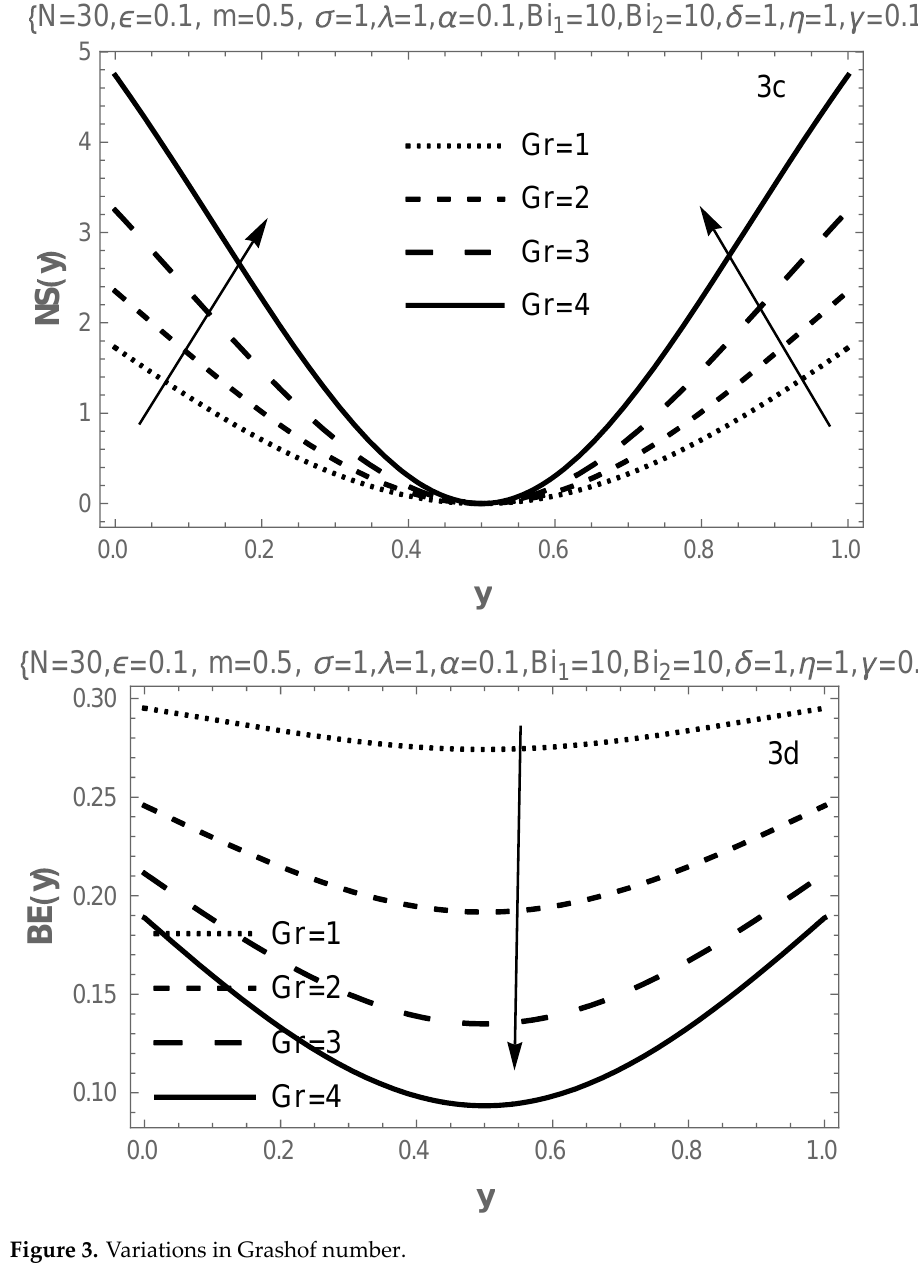
Figure 3. Variations in Grashof Figure -3. Variations in Grashof number.